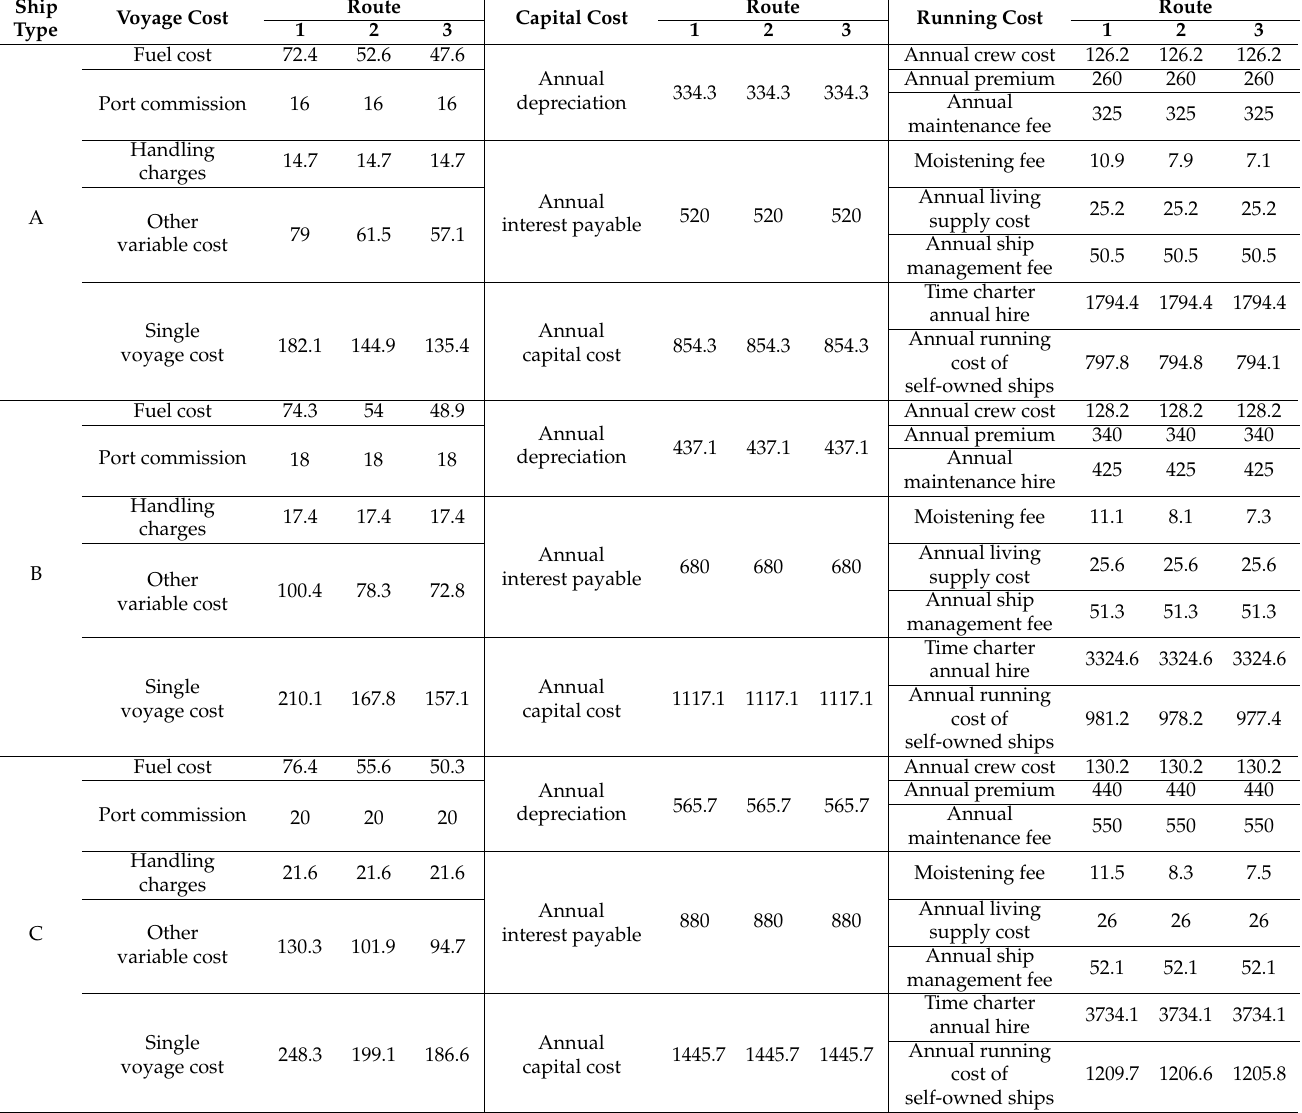
Table 5. Cost calculation table (Unit: 10 4 USD).